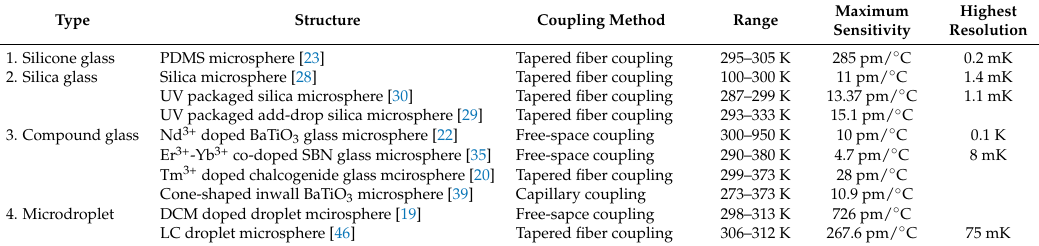
Table 1. Comparison of sensing parameters for different microsphere temperature sensors reviewed in this article.